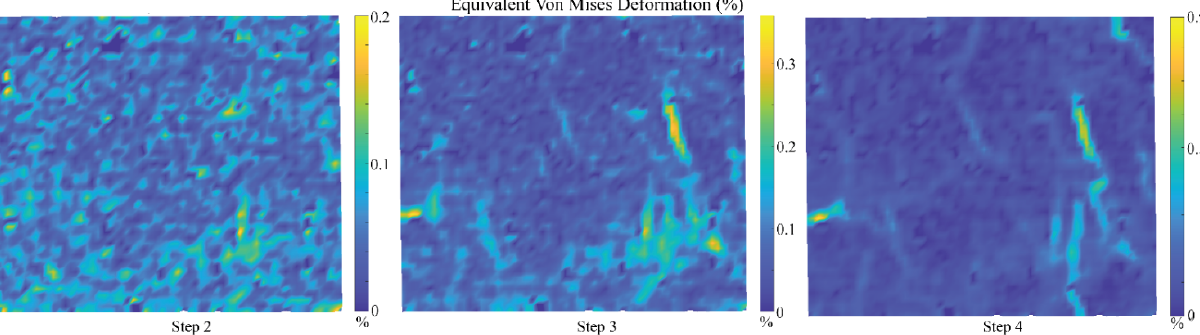
Figure 8. Map of the percentage of deformation from steps 2, 3, 4 of the experiment. The applied force being at 20.3° downward along the x-axis. Each picture is 800 µm wide.